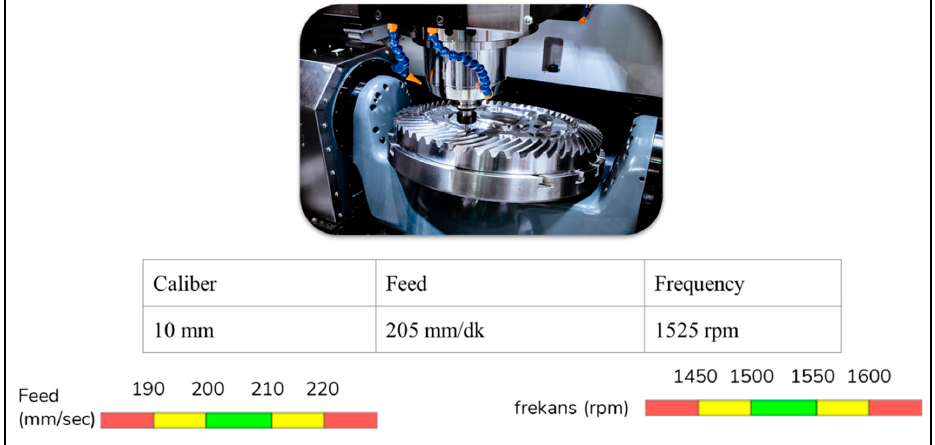
Figure 4. The visual representation of the optimum frequency and feed range of the chosen CNC.